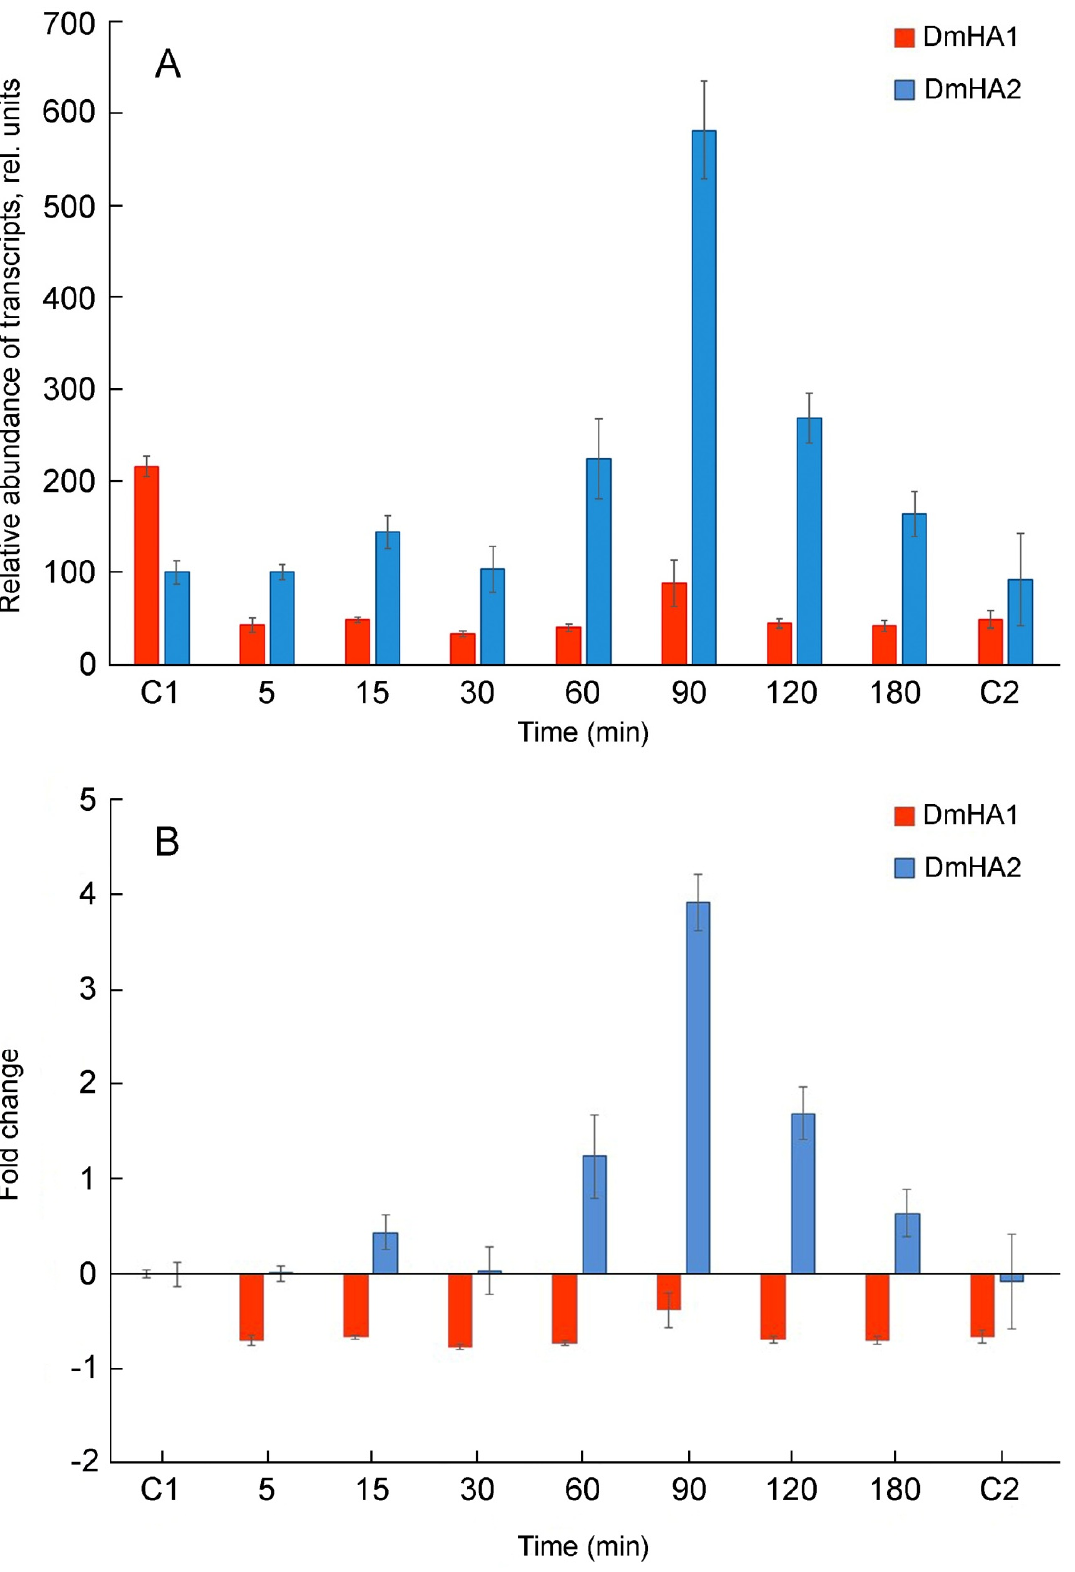
Figure 4. qRT-PCR analysis of DmHA1 and DmHA2 expression during the response of D. maritima cells to hyperosmotic salt shock. Sodium concentration in the medium was dramatically increased at “zero” time point. Points “C1” and “C2” represent the values of the expression of the ATPase genes in the algal cells growing at 0.1 M NaCl and 0.5 M NaCl in the medium, respectively. ( A ) relative abundance of transcripts; ( B ) recalculated fold changes of gene expression.